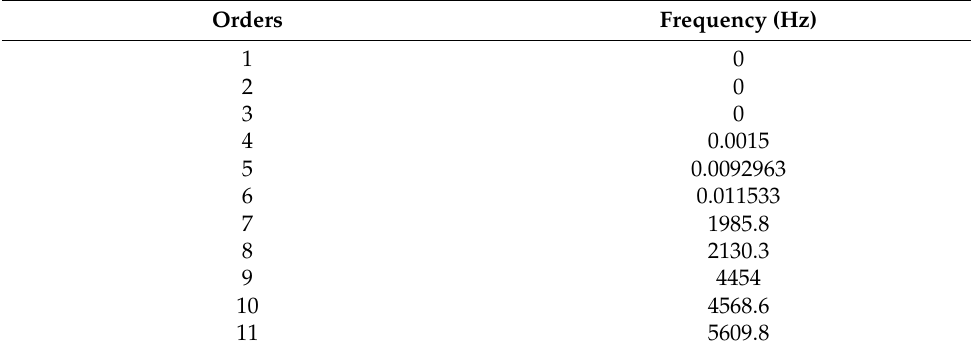
Table 5. The natural frequency of free